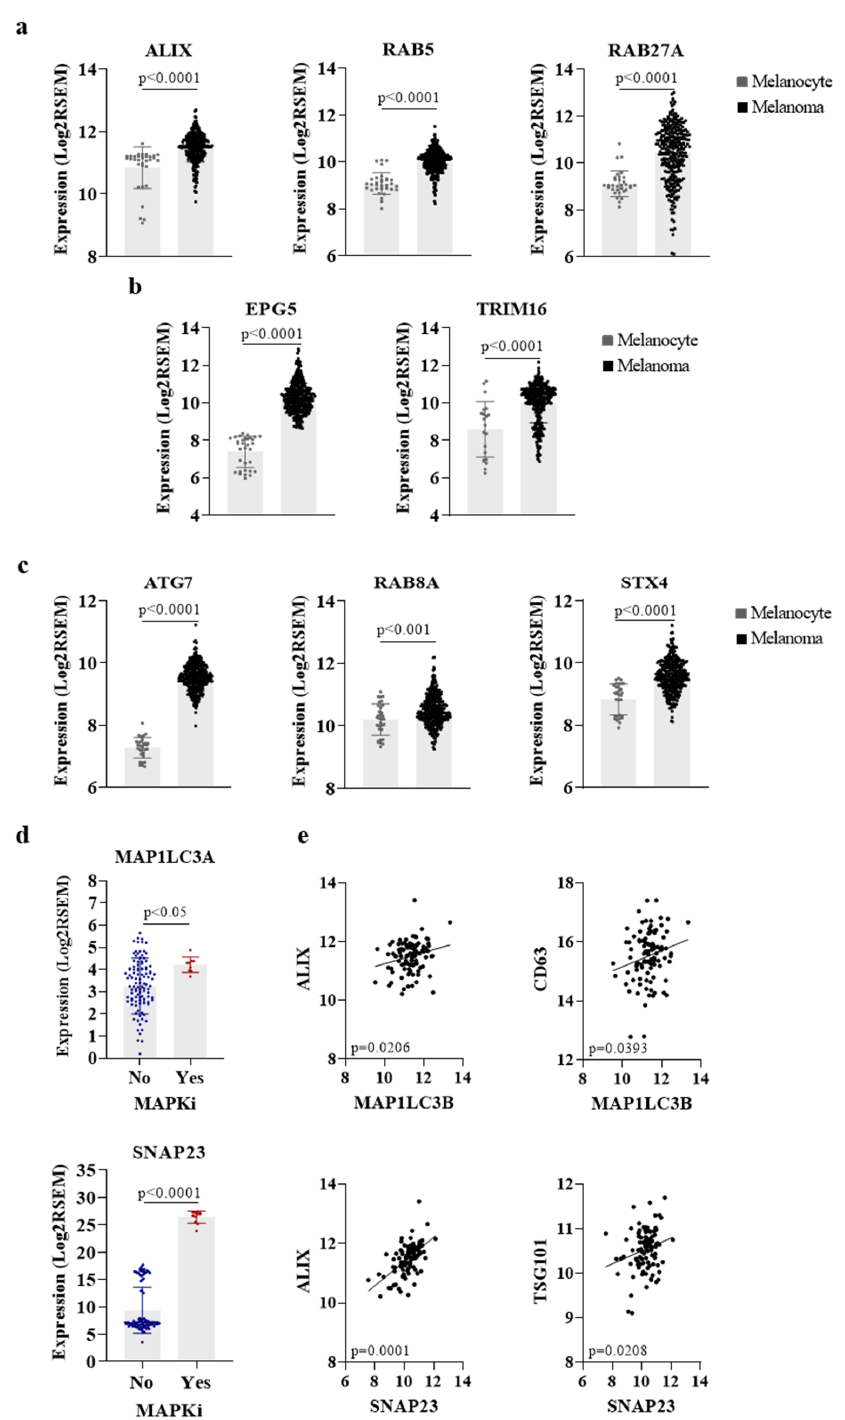
Figure 2. Melanoma presents a higher expression of genes involved in both exosomal and secretory autophagy pathways. ( a ) Expression of genes involved in exosome biogenesis, ( b ) secretory autophagy, ( c ) or both pathways in melanomas compared to non-transformed melanocytes. Gene expression data from melanocytes and melanoma tissues were downloaded from GENT2 platform (GSE30240) and cBioPortal (TCGA/SKCM/20160128), respectively. ( d ) Expression of autophagy- related genes after MAPK inhibitors treatment in SKCM. Data downloaded from cBioPortal (DFCI Nature Medicine/2019). ( e ) Correlation between the expression of LC3 and SNAP23 with exosome markers in SKCM. Data from TCGA/SKCM/20160128. Figures created in Gradphad Prism